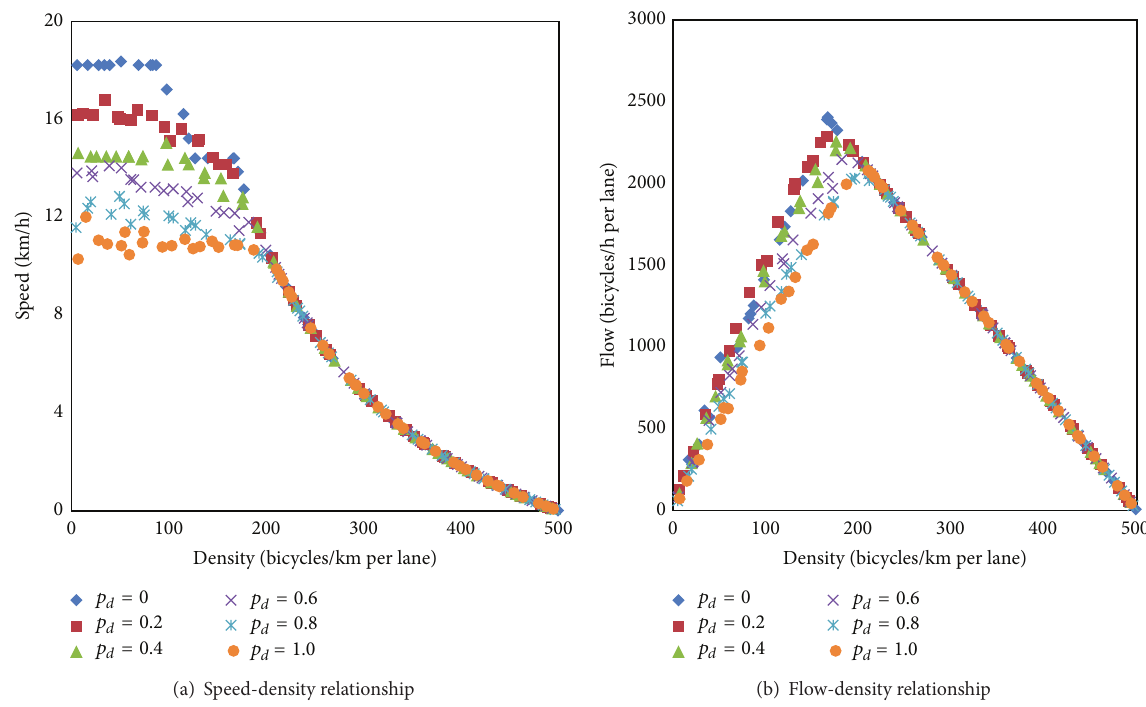
Figure 4: Speed-density and flow-density relationships under different slowing down probabilities of RBs and EBs when 𝑝 𝑒 = 0.5.